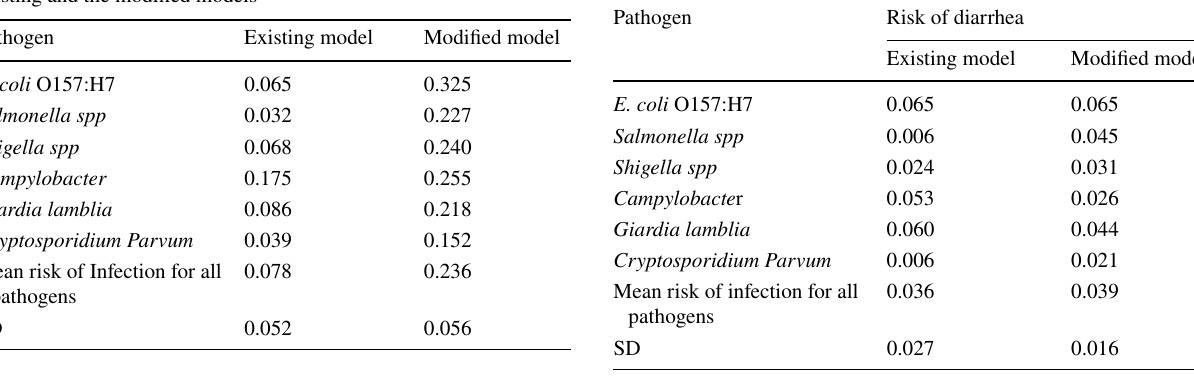
Table 15 t -Table computations for test of hypothesis Ho = x x 1: 1 2